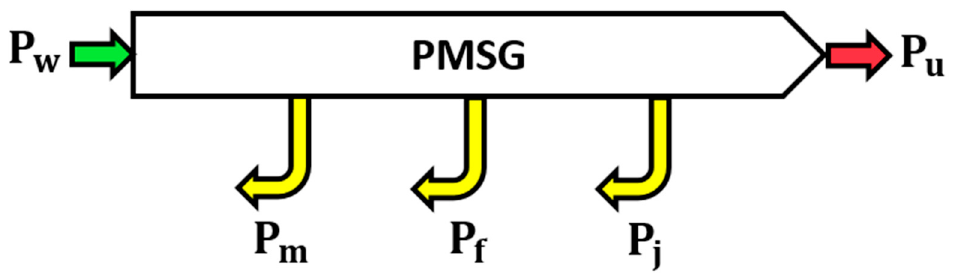
Figure 3. Permanent magnet synchronous generator power